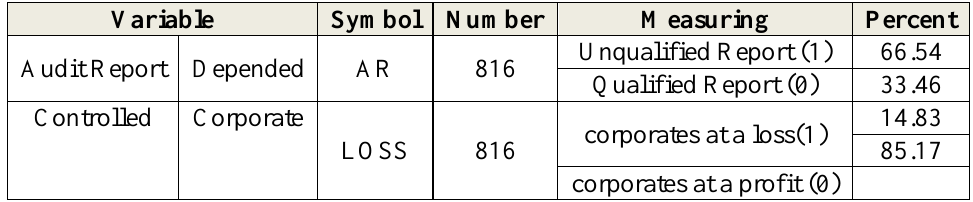
Table 3: Indicators describing research nominal